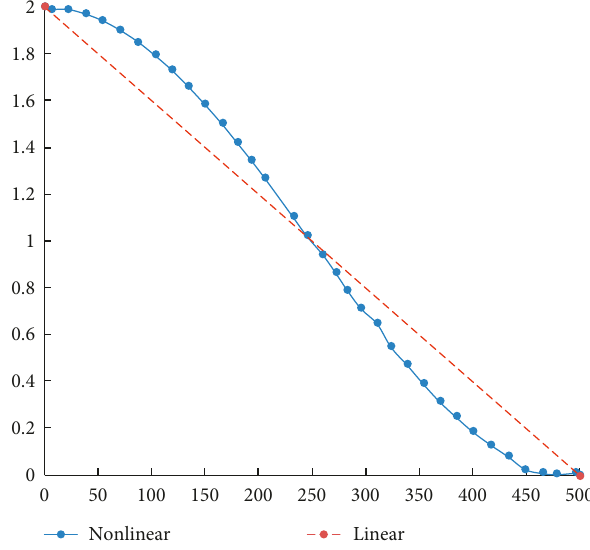
Figure 2: Convergence factor comparison